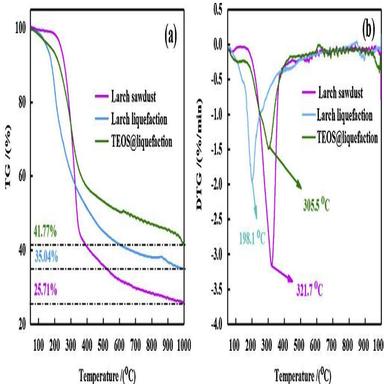
(a) TG and (b) DTG characteristics for the original larch sawdust, the liquefied larch sawdust and the TEOS-doped liquefied larch sawdust.